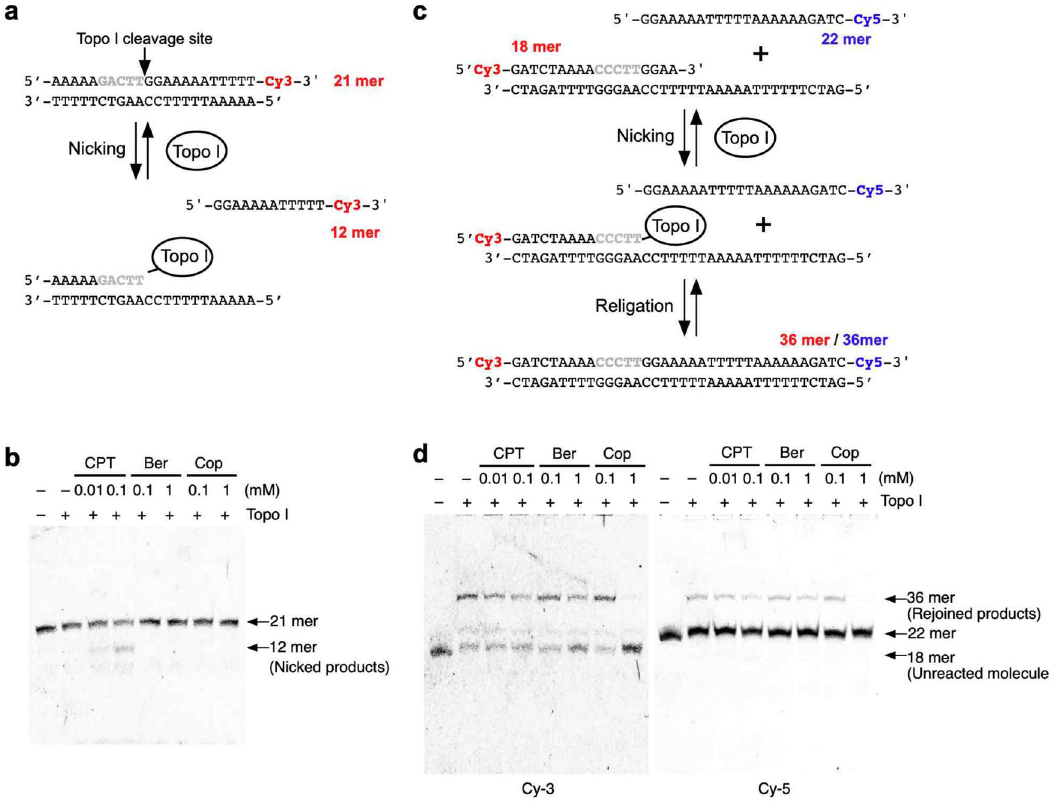
Figure 5. Analysis of the inhibitory effects of BIAs in nicking and rejoining assays. ( a ) Schematic representation of the nicking assay. Nicked DNA products were detected by the Cy-3 fluorescent signal. Unaffected DNA molecules were detected as 36-mer fragments, and nicked DNAs were detected as 22-mer fragments. ( b ) Inhibitory effects of treatment with CPT, berberine (Ber), and coptisine (Cop) on Topo I-dependent nicking activity. ( c ) Schematic representation of the rejoining assay. The rejoined products were detected by Cy-3 and Cy-5 fluorescent signals. Unaffected DNA molecules were detected as 18-mer fragments on a Cy-3-visualized gel, and nicked DNAs were detected as 36-mer fragments on both the Cy-3- and Cy-5-visualized gels. ( d ) Inhibitory effects of treatment with CPT, berberine (Ber), and coptisine (Cop) on Topo I-dependent re-joining